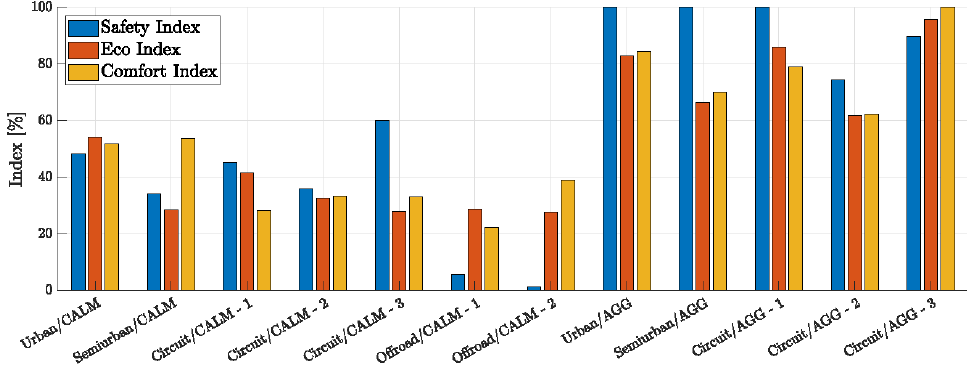
Figure 21. Safety, Eco, and Comfort Indices evaluated for a variety of tests. The label AGG is used to denote aggressive driving tests, where as the label CALM is used to denote calm driving